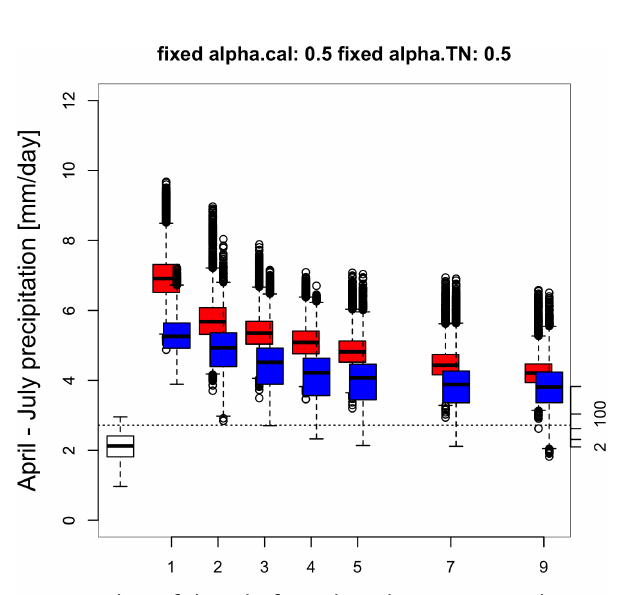
Figure A4. Distribution of April–July daily precipitation in obser- vations (white) and in simulations computed by the static (blue) and dynamic (red) generators as a function of the number of days before selecting a new analogue n days . The axis on the right indicates the probability of occurrence, assuming a normal distribution of daily precipitation with parameters estimated from white boxplot. The horizontal dotted line corresponds to the observed daily precipita- tion in April–July 2016. The boxes of boxplots indicate the median ( q 50), lower ( q 25), and upper ( q 75) quartiles. The upper whiskers indicate min[max( T ), 1 . 5 × ( q 75 − q 25)]. The lower whisker has a symmetrical formulation. The points are the simulated values that are above or below the defined